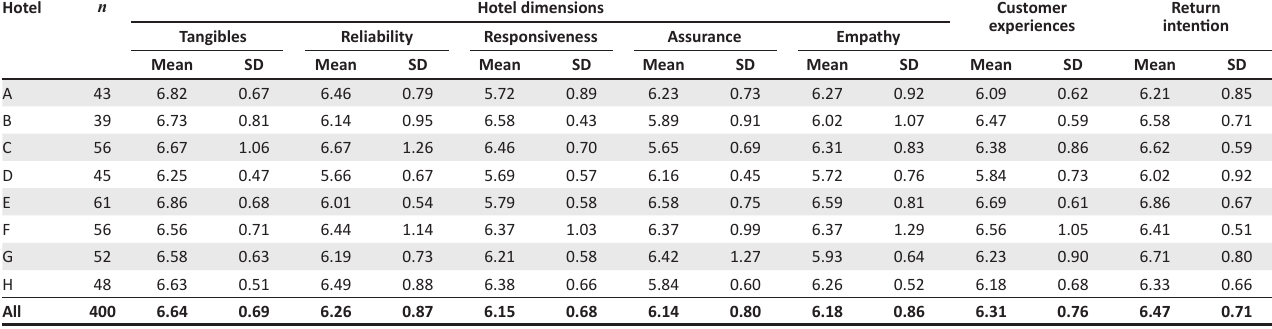
TABLE 5: Means and standard deviations for the five hotel dimensions, customer experiences and return intention in different hotels. Hotel n